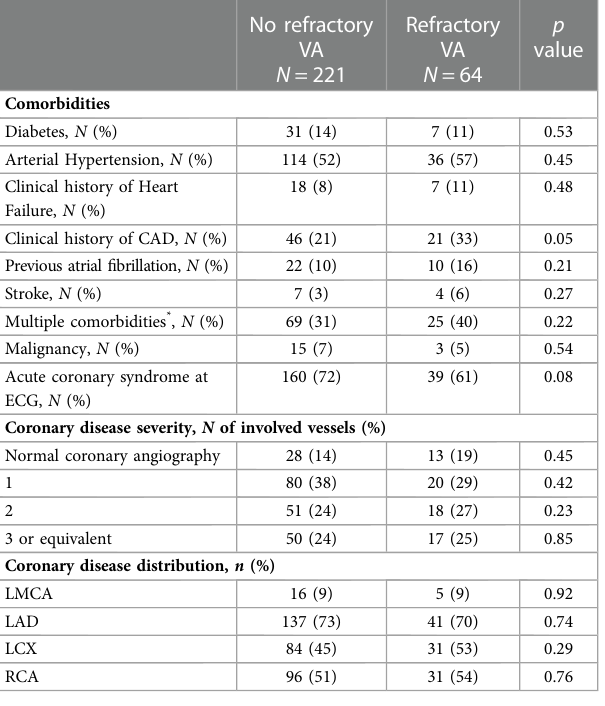
TABLE 2 Comorbidities, cardiovascular risk factors and distribution and severity of CAD in OHCA survivors admitted to urgent coronary angiography.